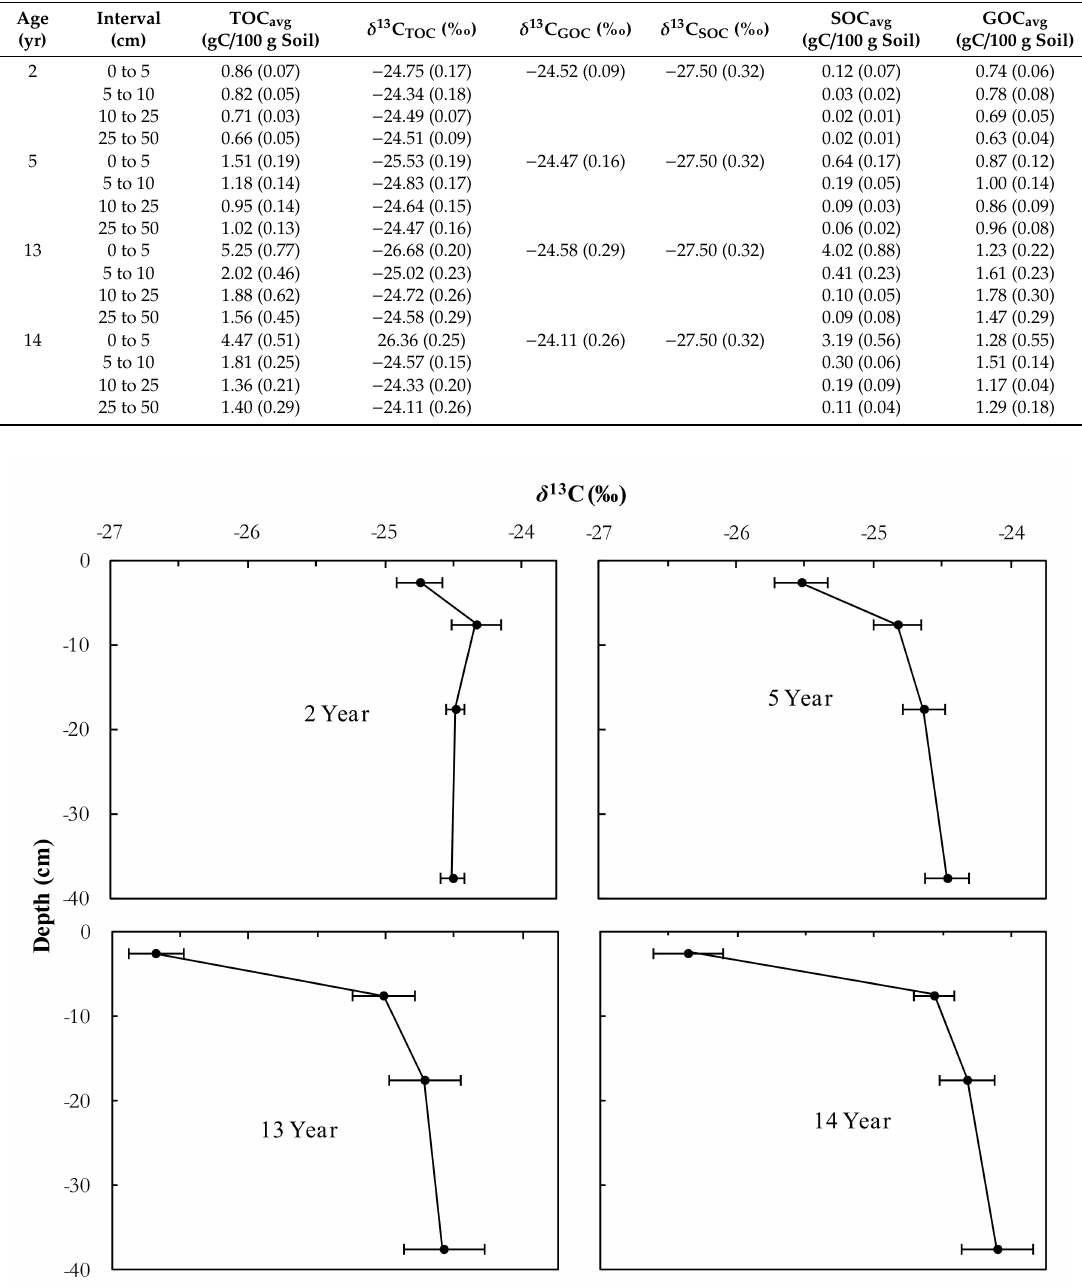
Table 1. Results of ARRI soil carbon analysis. Parentheses indicate ± 1 SE.